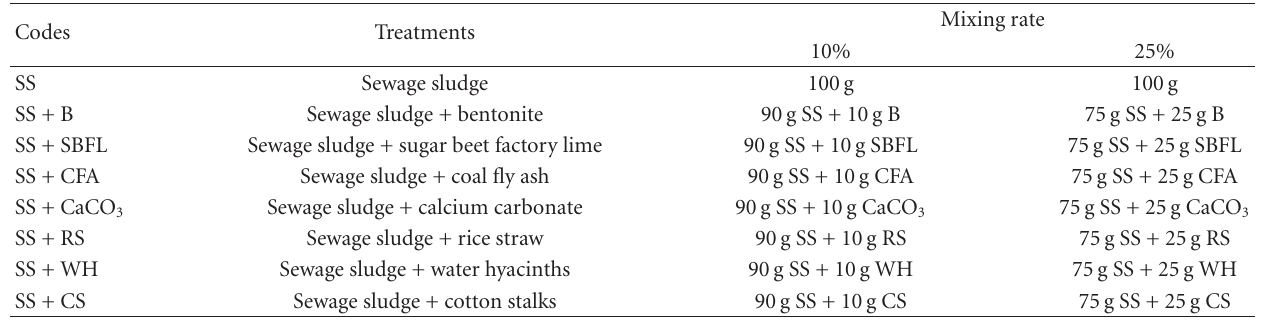
Table 1: Treatments of sewage sludge with the studied stabilized